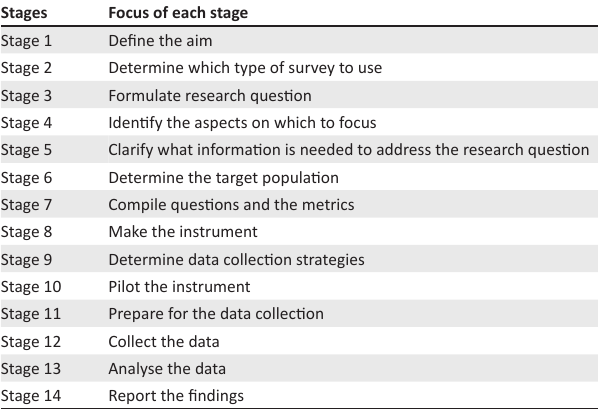
TABLE 2: Stages of questionnaire